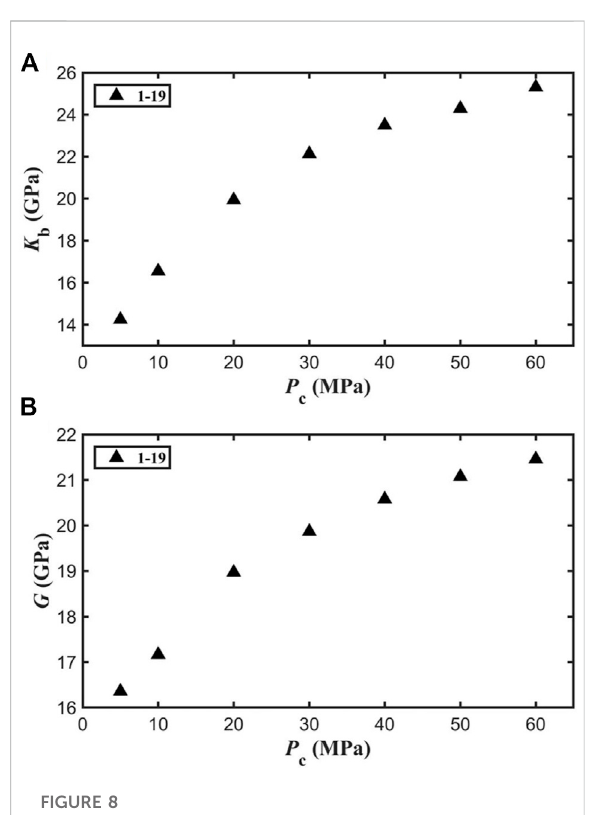
FIGURE 8 Estimated bulk (A) and shear (B) moduli of the dry rocks for sample 1 –